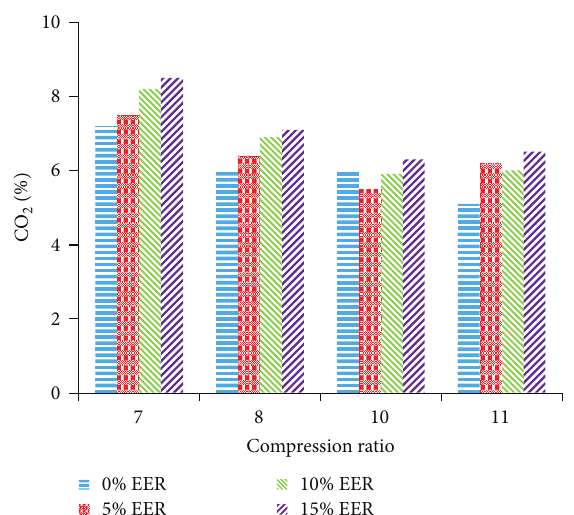
Figure 12: Effect of compression ratio on UHC concentration for different EER at 1200rpm and load 14 N ⋅ m.